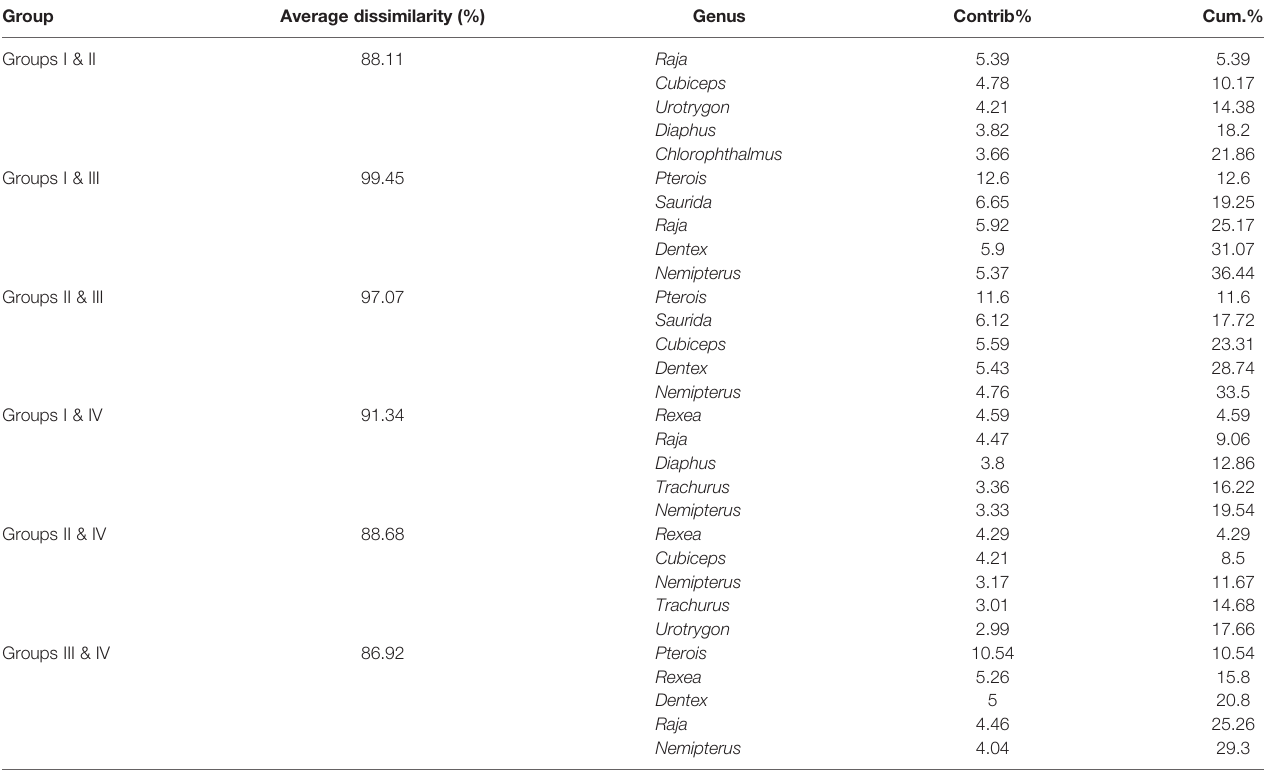
TABLE 5 | Average dissimilarity and top fi ve discriminating genera among group I, II, III, and IV over the NCSSCS. Group Average dissimilarity (%) Genus Contrib%